Question: Provide a one-line summary of what is displayed.
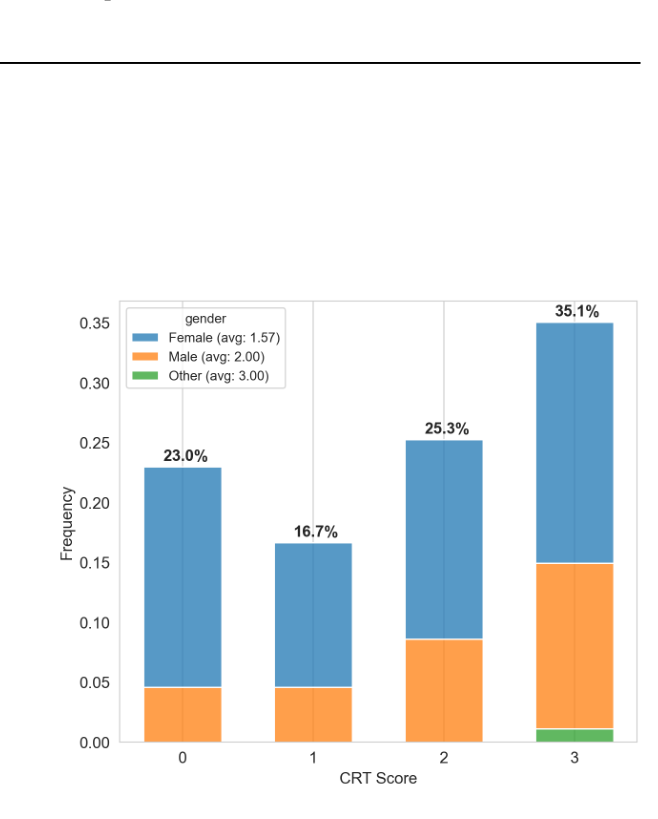
Answer: Participant’s Cognitive Reflection Test (CRT) score distribution.